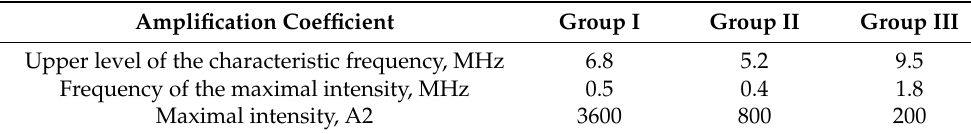
Table 5. Spectral characteristics of the current impulse of streamer corona on the elongated model elements (average